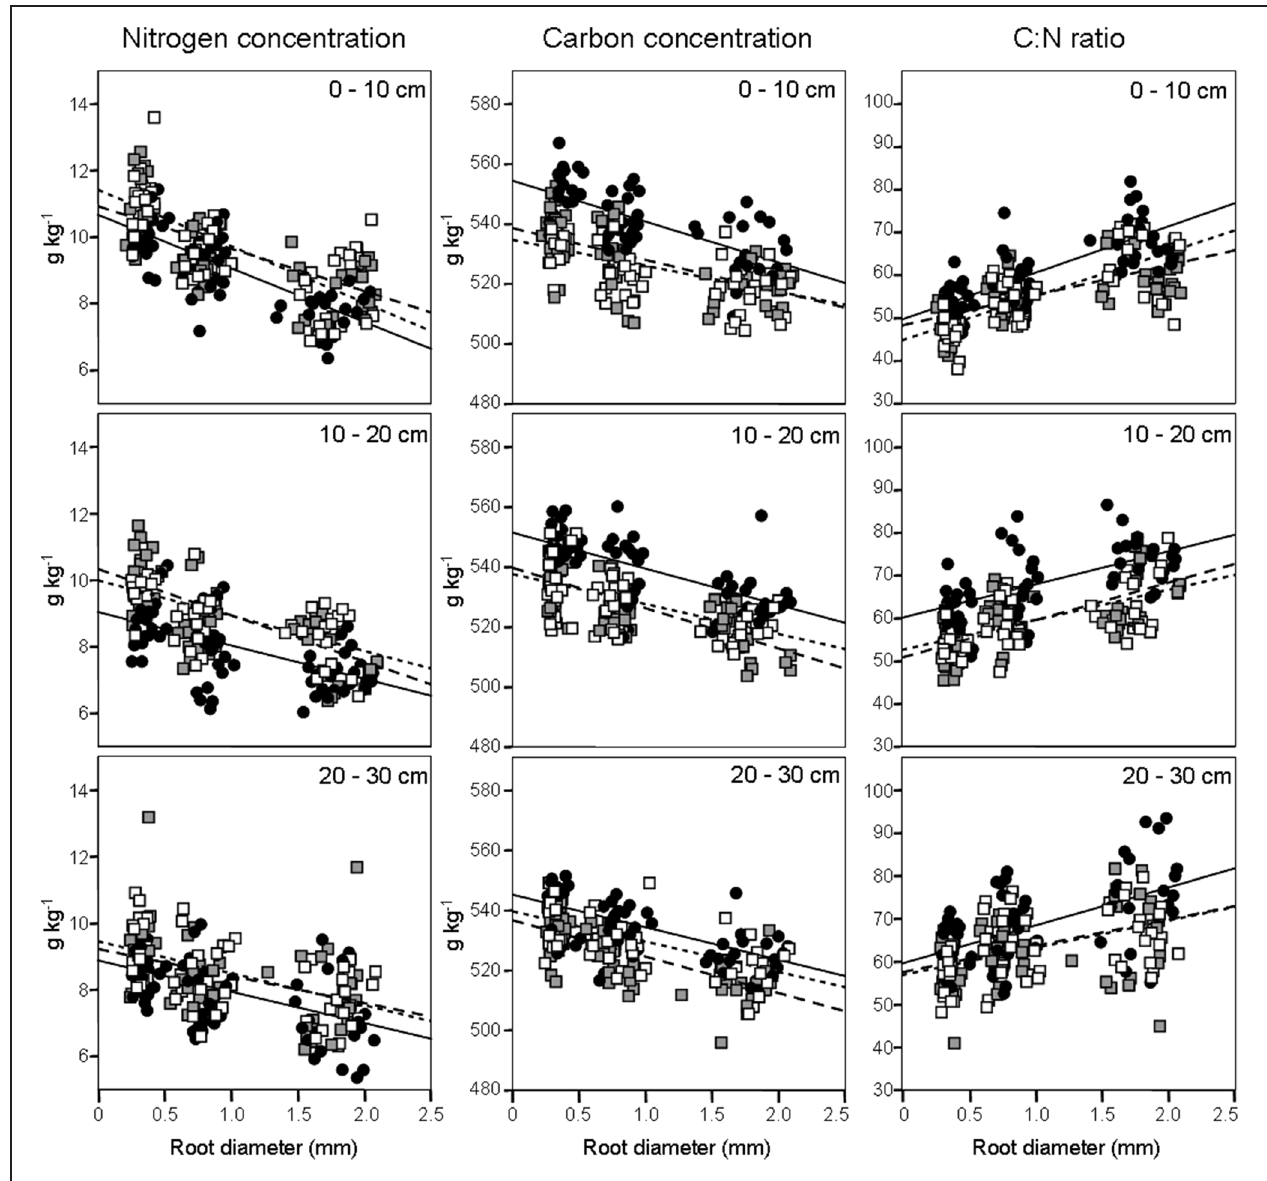
FIGURE 1 | Fine-root nitrogen and carbon concentrations and C:N ratio ( columns ), according to soil depths ( rows ), in relation to root diameter. Data refer to 6 sampling dates between 8 May and